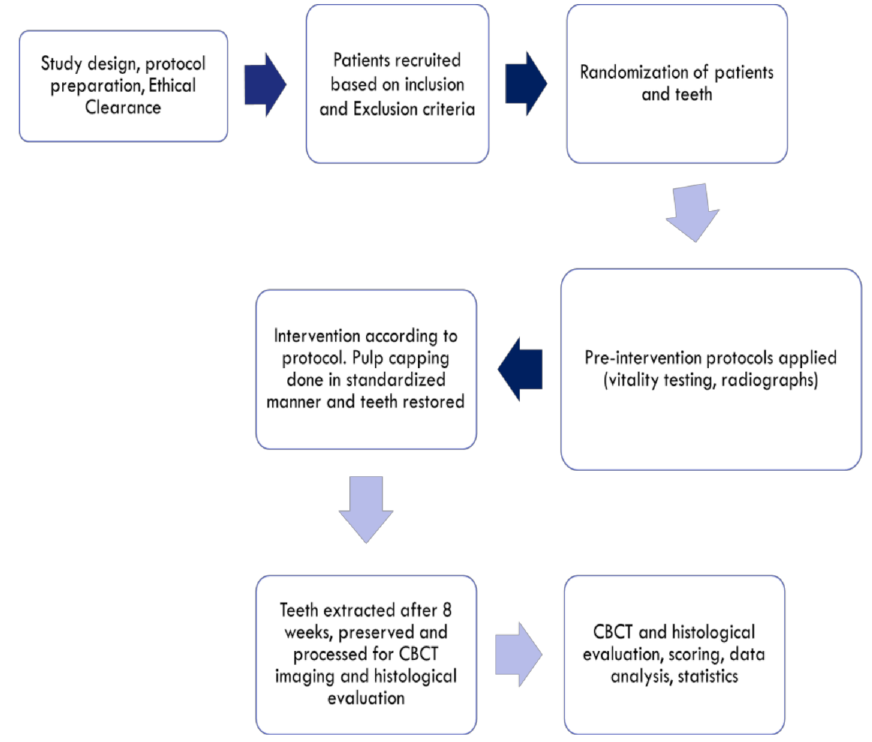
Figure 1. Flowchart of the